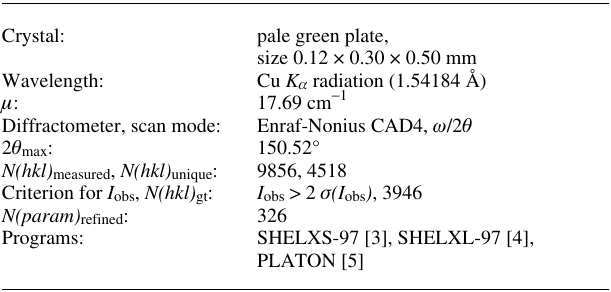
Table 1. Data collection and